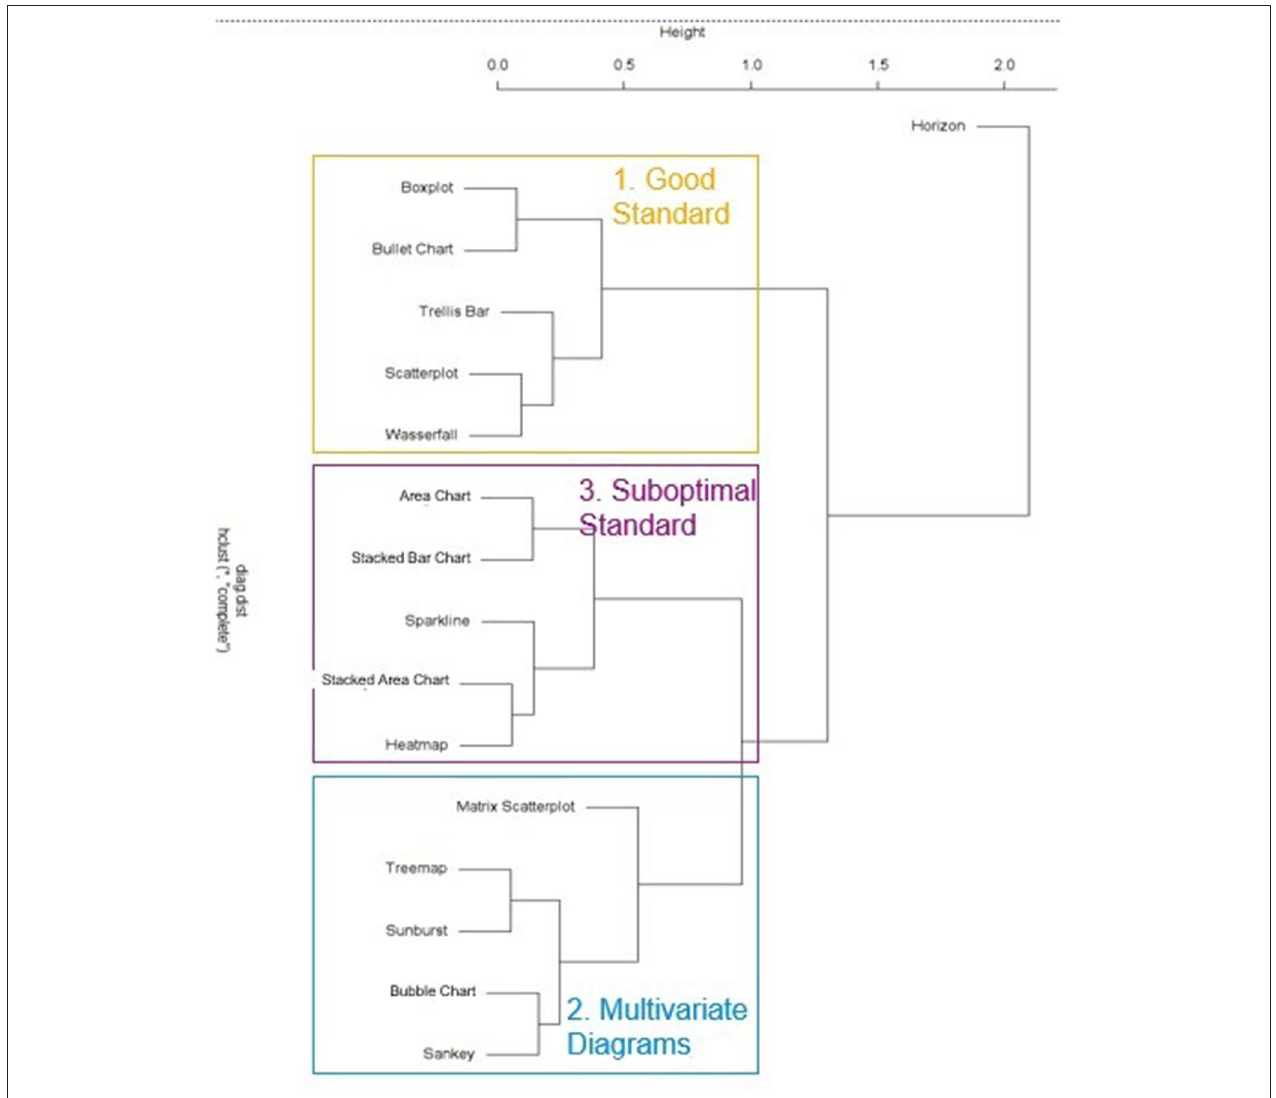
FIGURE 2 | Study 2: Dendrogram of visualization